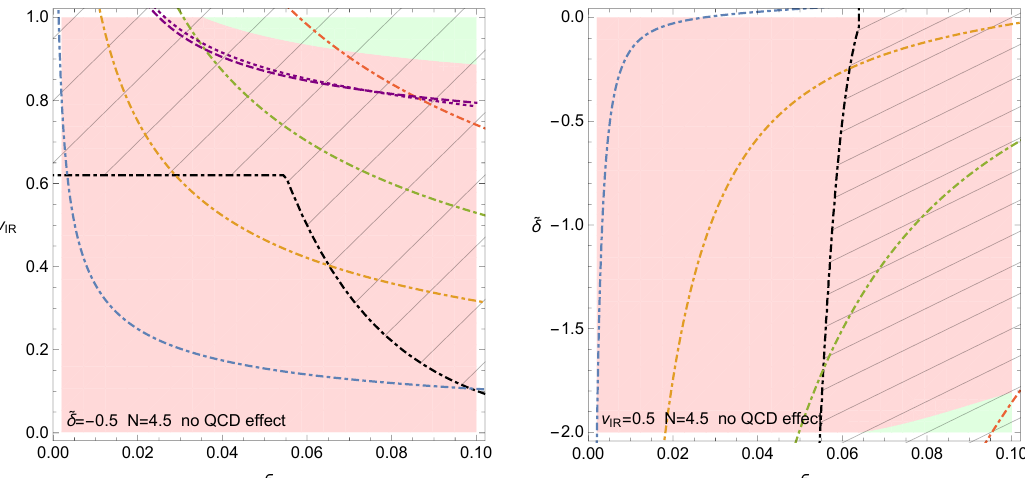
Figure 4 . Results for (cid:22) min = 2 : 5 TeV and N = 4 : 5 without the QCD e(cid:11)ect. For the left panel, we have (cid:12)xed ~ (cid:14) = (cid:0) 0 : 5, and for the right panel, v = 0 : 5. Regions where the phase transition can IR complete via the nucleation of O (4)-symmetric bubbles are shown in green, while regions where the nucleation rate is too low are colored in red. Regions above the purple dashed and dotted lines are allowed according to the analytical estimate of the bubble action for O (4)- and O (3)-symmetric bubbles, respectively. In the hashed region (above the black, dashed line in the left panel and to right of the black, dashed line in the right panel), the backreaction constraint is not ful(cid:12)lled. The blue, orange, green, red dashed-dotted lines (from bottom to top in the left panel and in the reversed order in the right panel) correspond to the radion mass being m radion = 200 GeV ; 600 GeV ; 1 TeV ; 1 : 4 TeV,